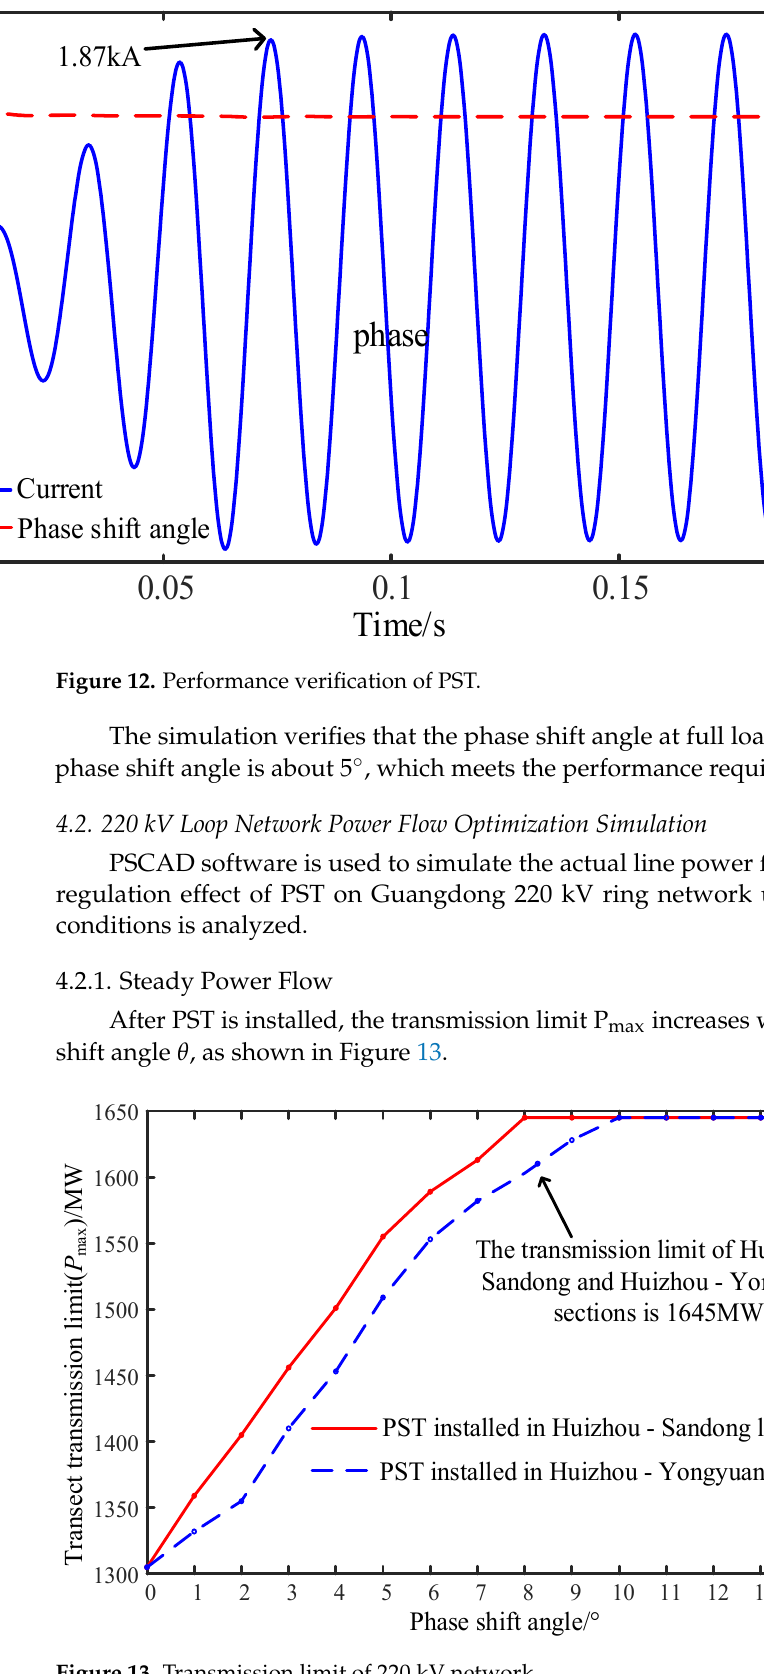
Figure 13. Transmission limit of 220 kV network .